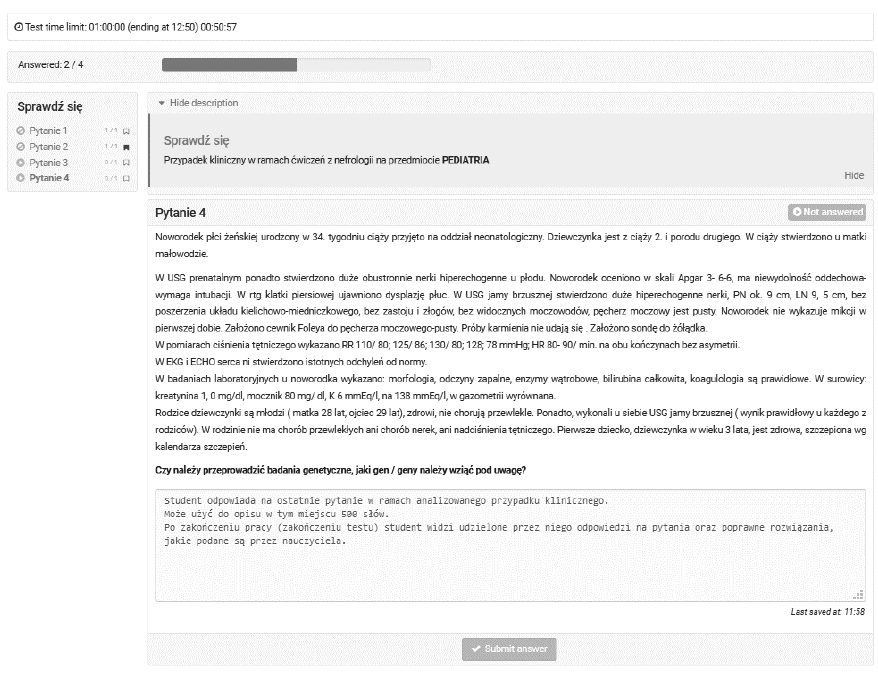
Figure 11. E-learning course in Pediatrics for year 5 students at the faculty of Medicine. Example open-ended question in a clinical case-based